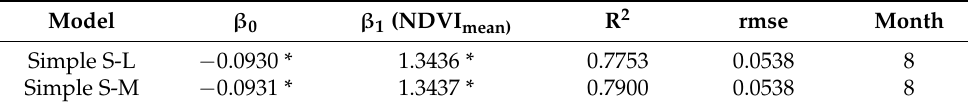
Table 7. R-squared, rmse, month and best fit model for simple regression (* p -values: <0.05). Model